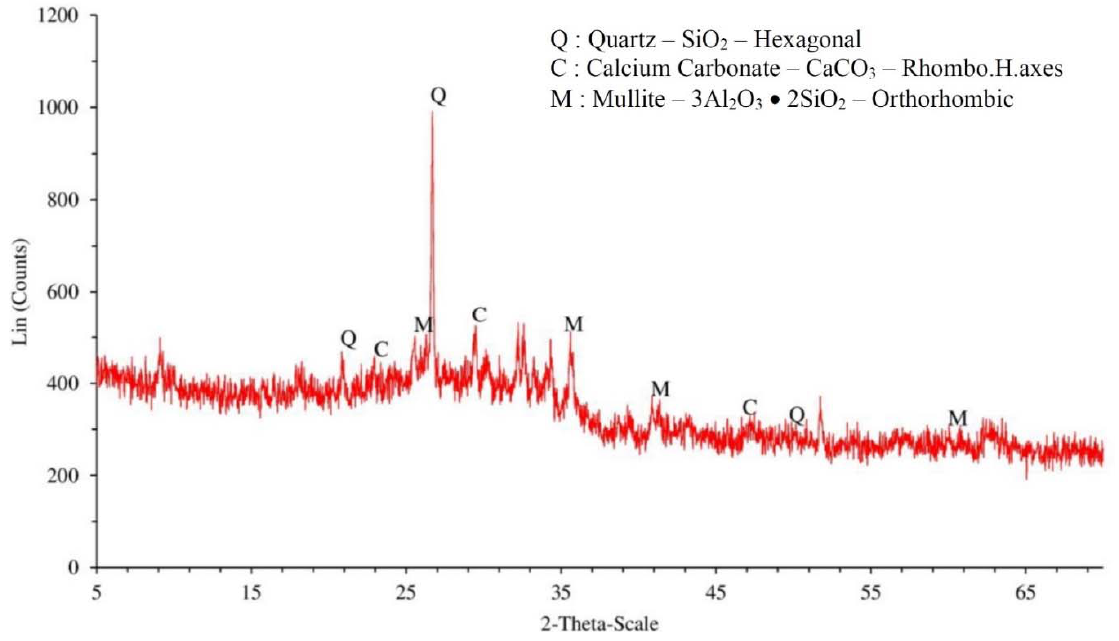
Figure 1. The qualitative results (XRD) of 5FA.